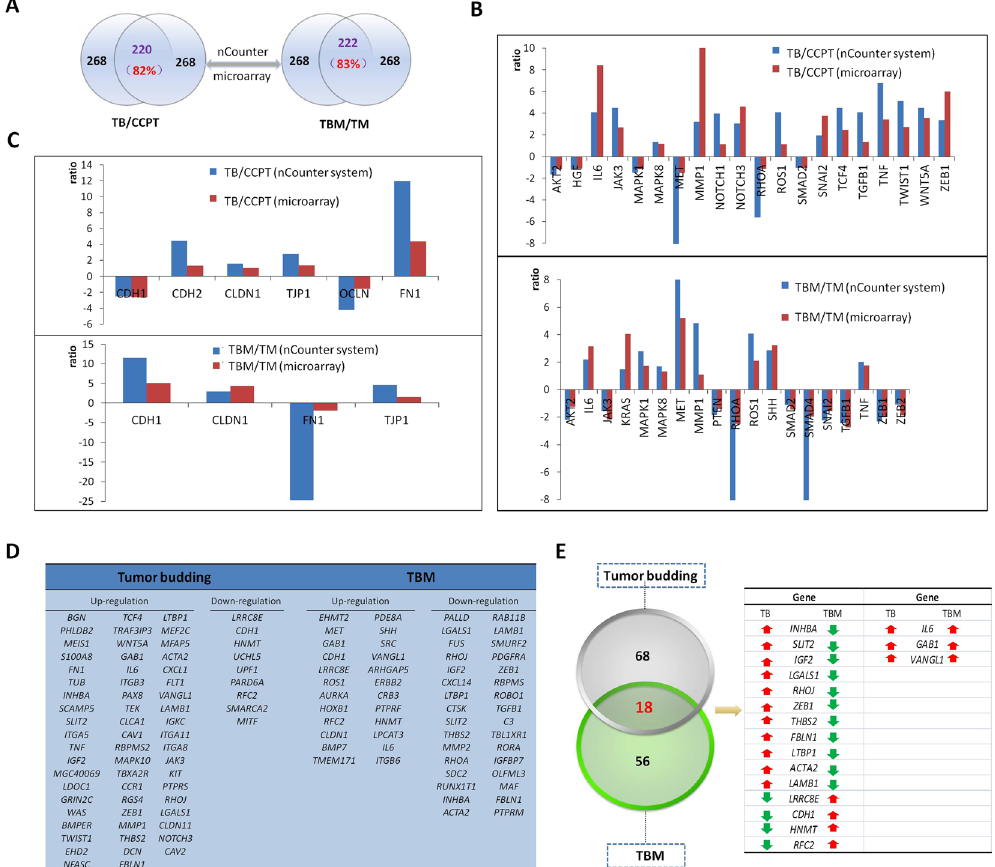
Figure 5. The primary identification of differentially expressed genes with the nCounter system. ( A ) The primary identification results of the 268 candidate genes with the nCounter system. In tumor buds, compared with CCPT, 220 differentially expressed genes had the same expression trend as in the microarray, accounting for 82% of the 268 candidate genes. Additionally, there were 222 genes in TBM that shared the same expression trend as TM, accounting for nearly 83% of the candidate genes. ( B ) The identification of classical EMT regulators in the tumor bud cells and their surrounding stromal cells. ( C ) The identification of classical epithelial and mesenchymal regulators. ( D ) In total, 106 genes, including 59 upregulated and 9 downregulated genes in the tumor buds and 24 upregulated and 32 downregulated genes in TBM, are shown (ratio > 2 & < − 2). ( E ) Eighteen of the 106 genes were differentially expressed in both the tumor bud samples and their surrounding mesenchymal